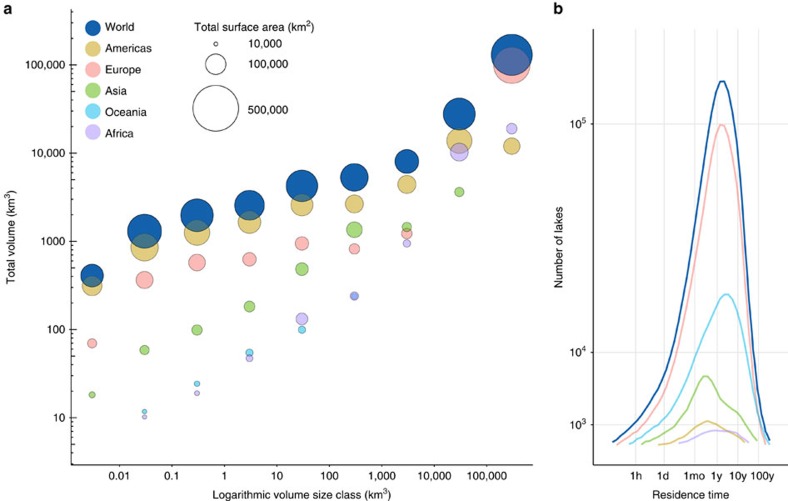
Distribution of global lakes sizes and hydraulic residence times.(a) Total volume of natural lakes in km3 and surface area in km2 across volume size classes by continent and for the world. (b) The frequency distribution of hydraulic residence times by continent and for the world. Colour legend in a refers to both panels. For definition of continents see Table 1. Note that Europe includes the Caspian Sea and Lake Baikal, the two most voluminous lakes on Earth.